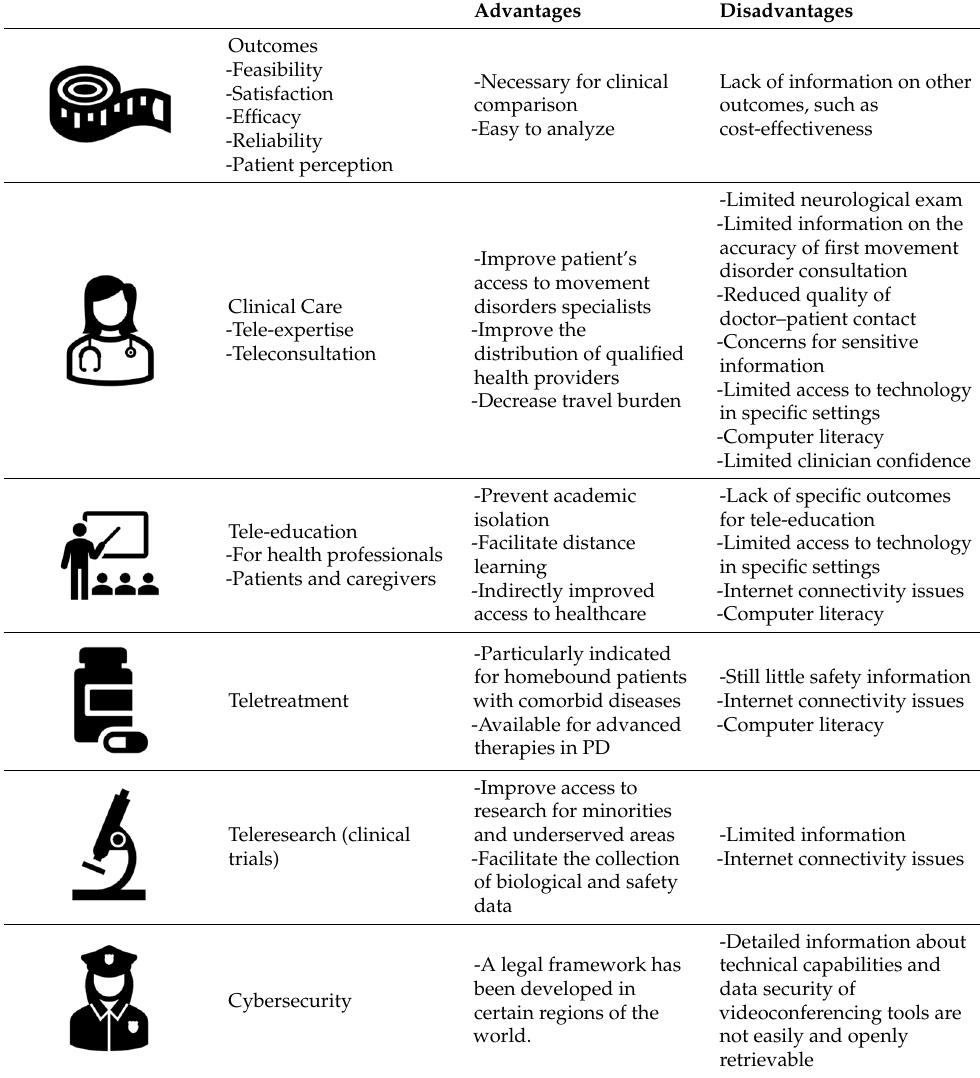
Table 1. Achievements and challenges of telemedicine.